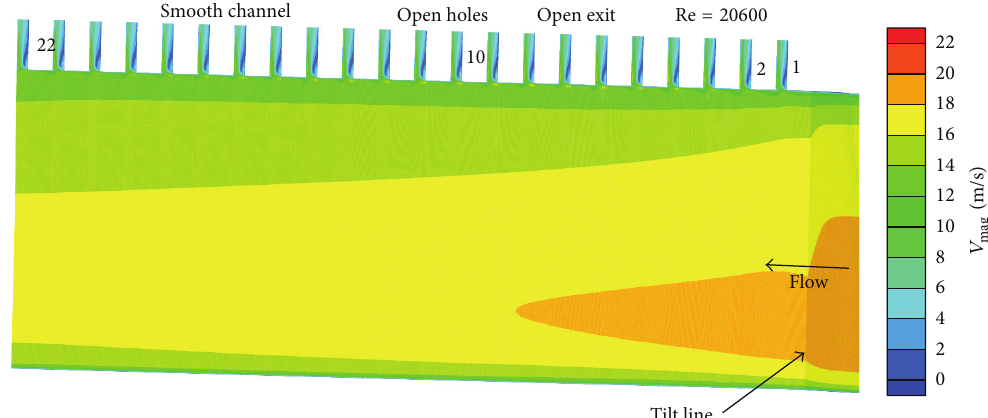
Figure 6: CFD contours of the velocity magnitudes on the channel mid-plane downstream the 22-degree tilt for the smooth wall case, open trailing-edge holes, and open channel